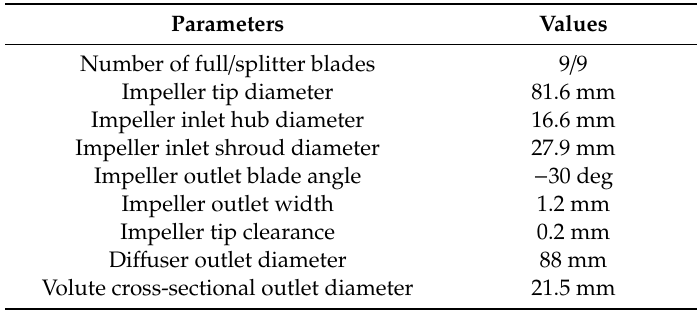
Table 6. Geometrical parameters of the optimal SCO 2 compressor stage.